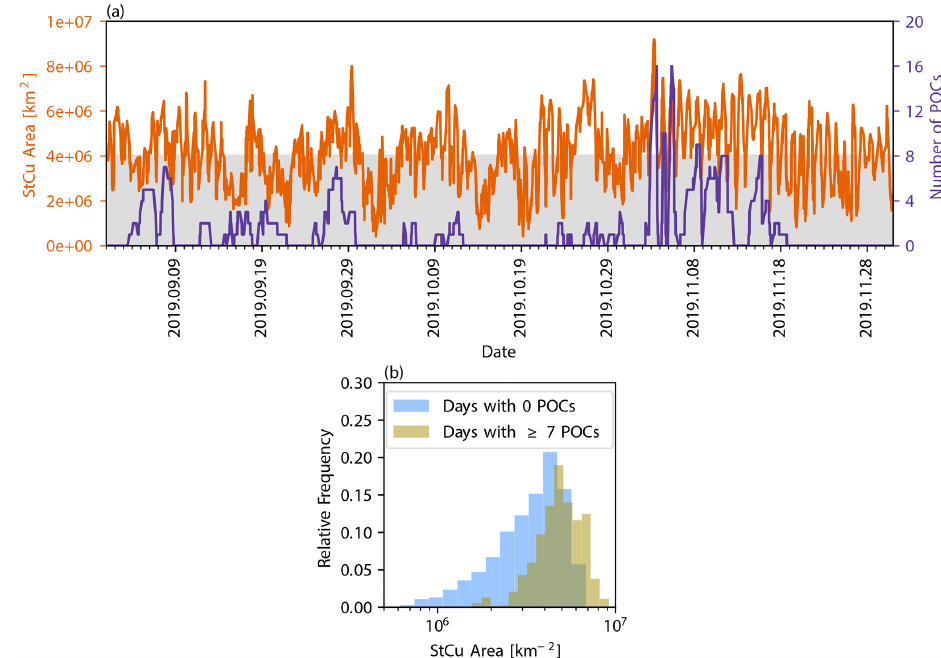
Figure 11. Changes in stratocumulus (StCu determined using 0.5–2km level 1.5 observations) and the number of pockets of open-cell StCu (POCs) every 10min are shown in panel (a) , and the distribution of affected areas for days with no POCs (blue) and days with ≥ 7 POCs (brown) are shown in panel (b)